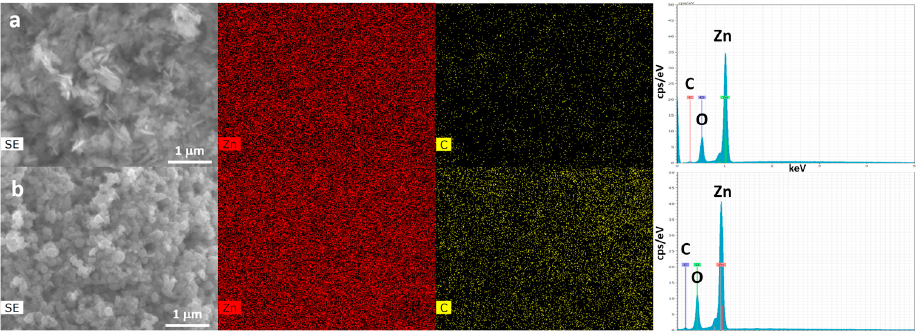
Figure 3. EDX elemental mapping of samples non-biogenic ( a ) and biogenic ( b ) ZnO-NPs.